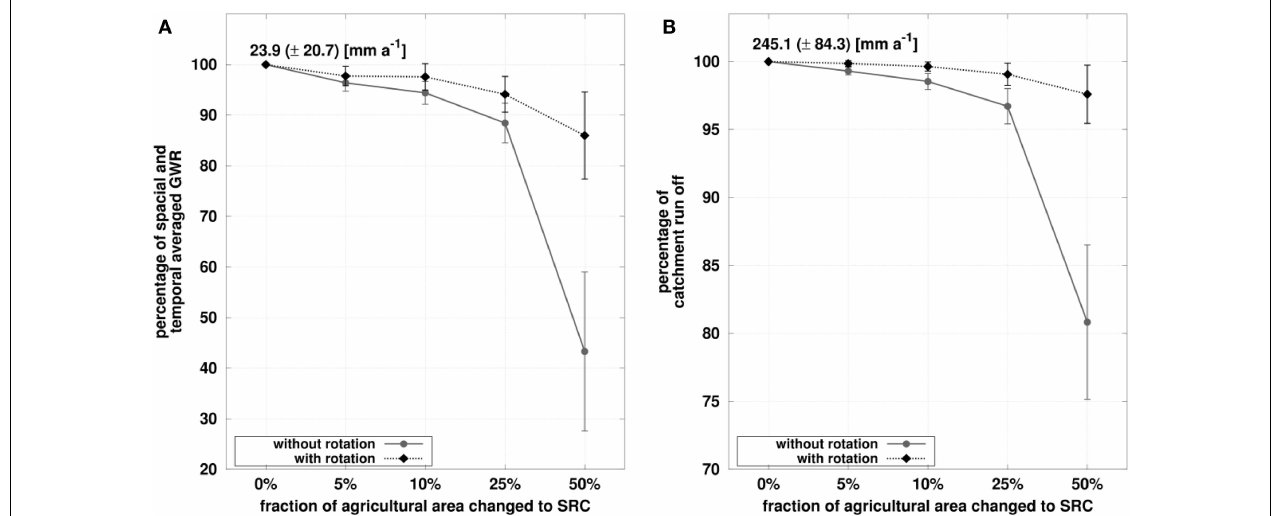
FIGURE 5 | Change of ground water recharge (GWR, spatial mean over catchment area) and catchment run off relative to reference simulation (0% SRC) . Mean values and SDs of relative changes are calculated over all simulated years, e.g., 30 for the simulations without rotation and 5 (cid:2) 30 for the simulations with rotation. (A) Percentage of spatial and temporal averages ground water recharge (GWR). (B) Percentage of catchment runoff.